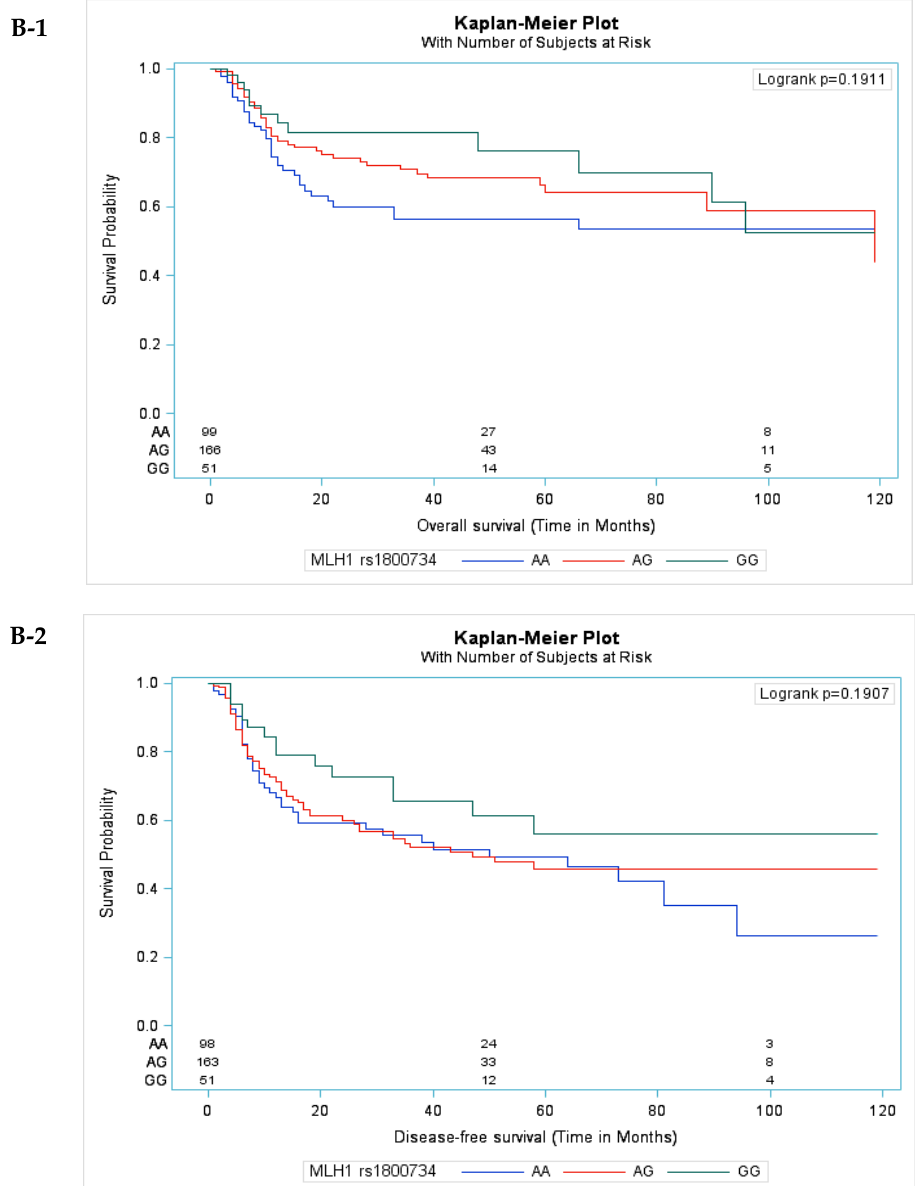
Figure 1. Kaplan–Meier analysis and log-rank test results of OS and DFS curves for the MSH2 rs3732183 and MLH1 rs1800734 polymorphisms in patients with oral squamous cell carcinoma treated with concurrent chemoradiotherapy. ( A-1 ) No significant difference in OS among the MSH2 rs3732183 genotypes (log-rank test p = 0.5185). ( A-2 ) The GG genotype showed a borderline significant better DFS time than the AA genotype (log-rank test p = 0.0887). ( B-1 , 2 ) No significant difference in death and recurrence among genotypes of MLH1 rs1800734 (log-rank test p = 0.1911 and p = 0.1907, respectively).